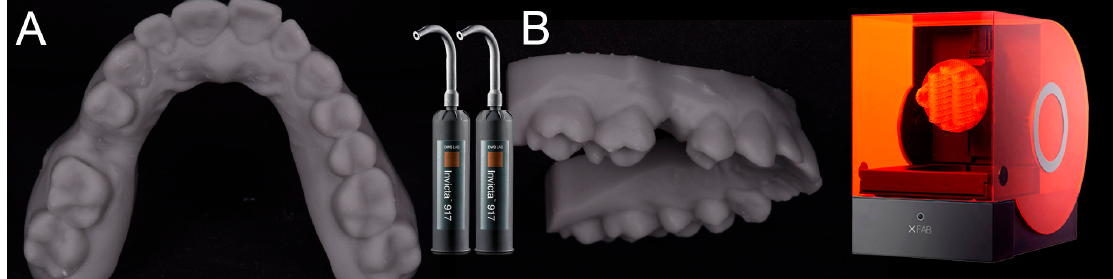
Figure 4. The models are printed in resin (Invicta917 ® ) with a desktop stereolithographic (SLA) 3D printer (XFAB2000 ® , DWS, Thiene, Italy). ( A ) Occlusal view. ( B ) Lateral view.